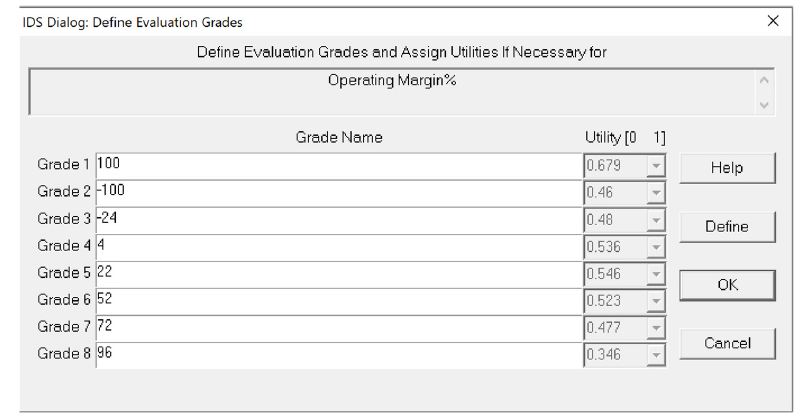
Figure 2. The discrete attribute grades definition.